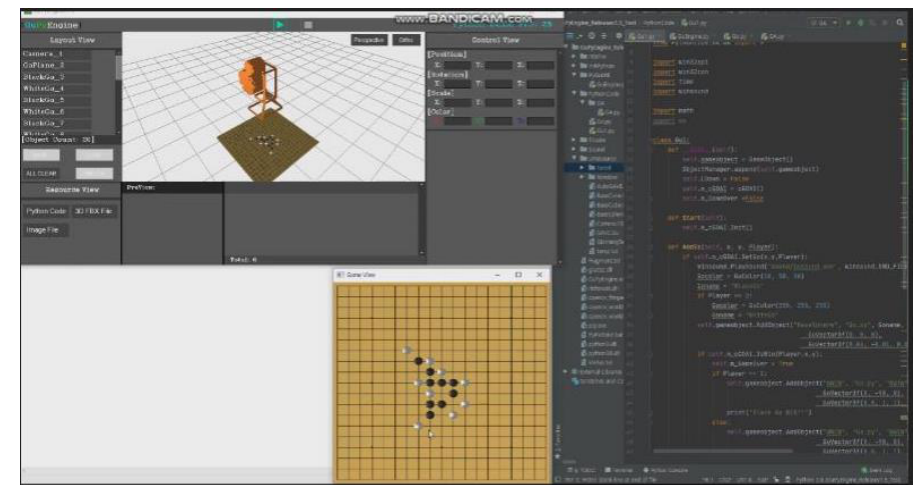
Figure 5. Proposed Gomoku system’s Python code in GupyEngine with Pycharm.